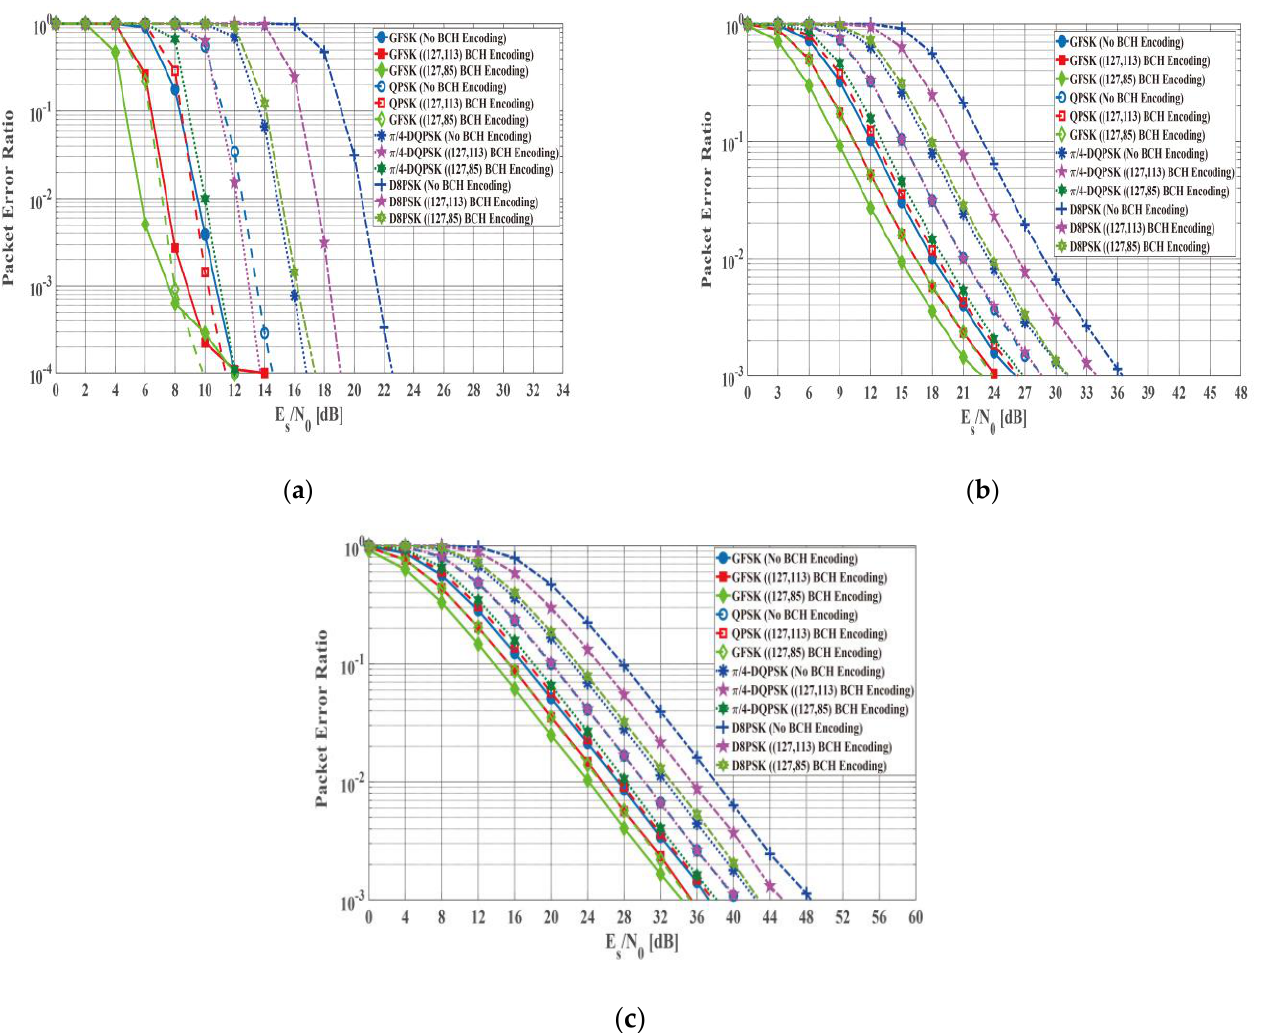
Figure 9. Packet error ratio in the case of several channel models. ( a ) AWGN. ( b ) IEEE model CM3 (medium shadowing